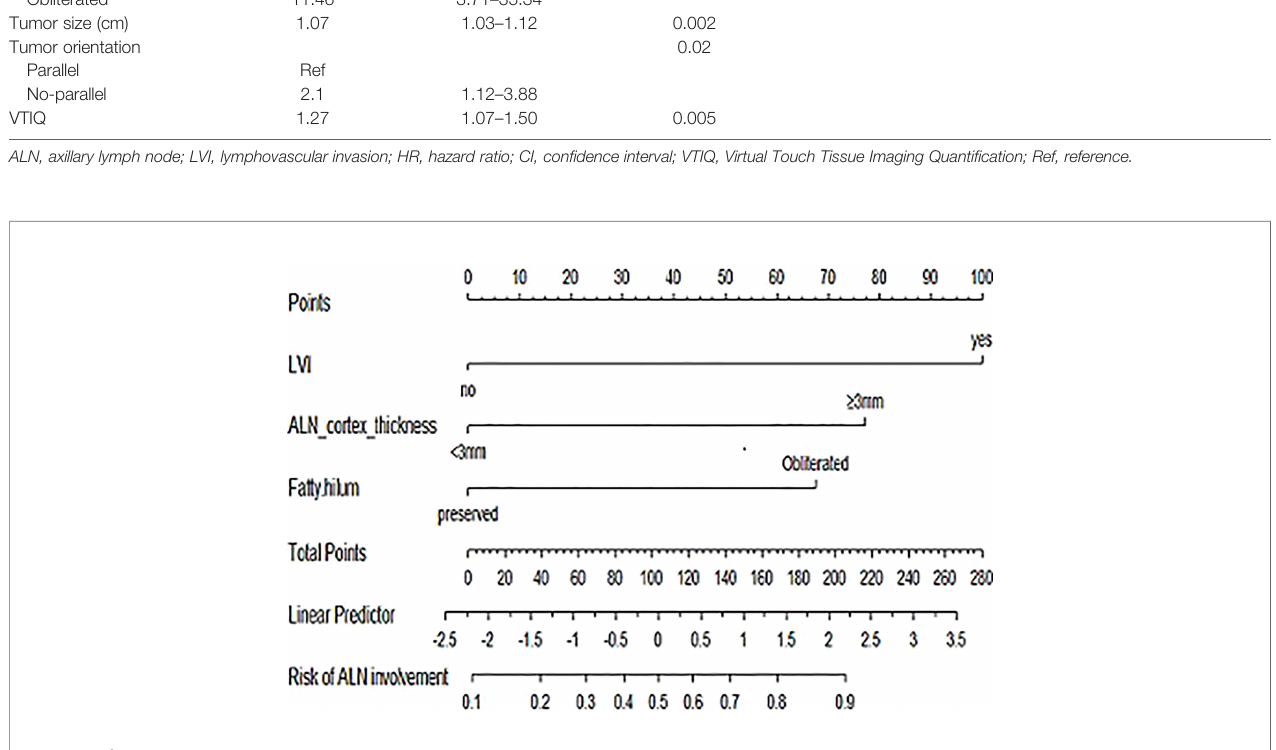
TABLE 3 | The AUC of the combined model and image-only model.